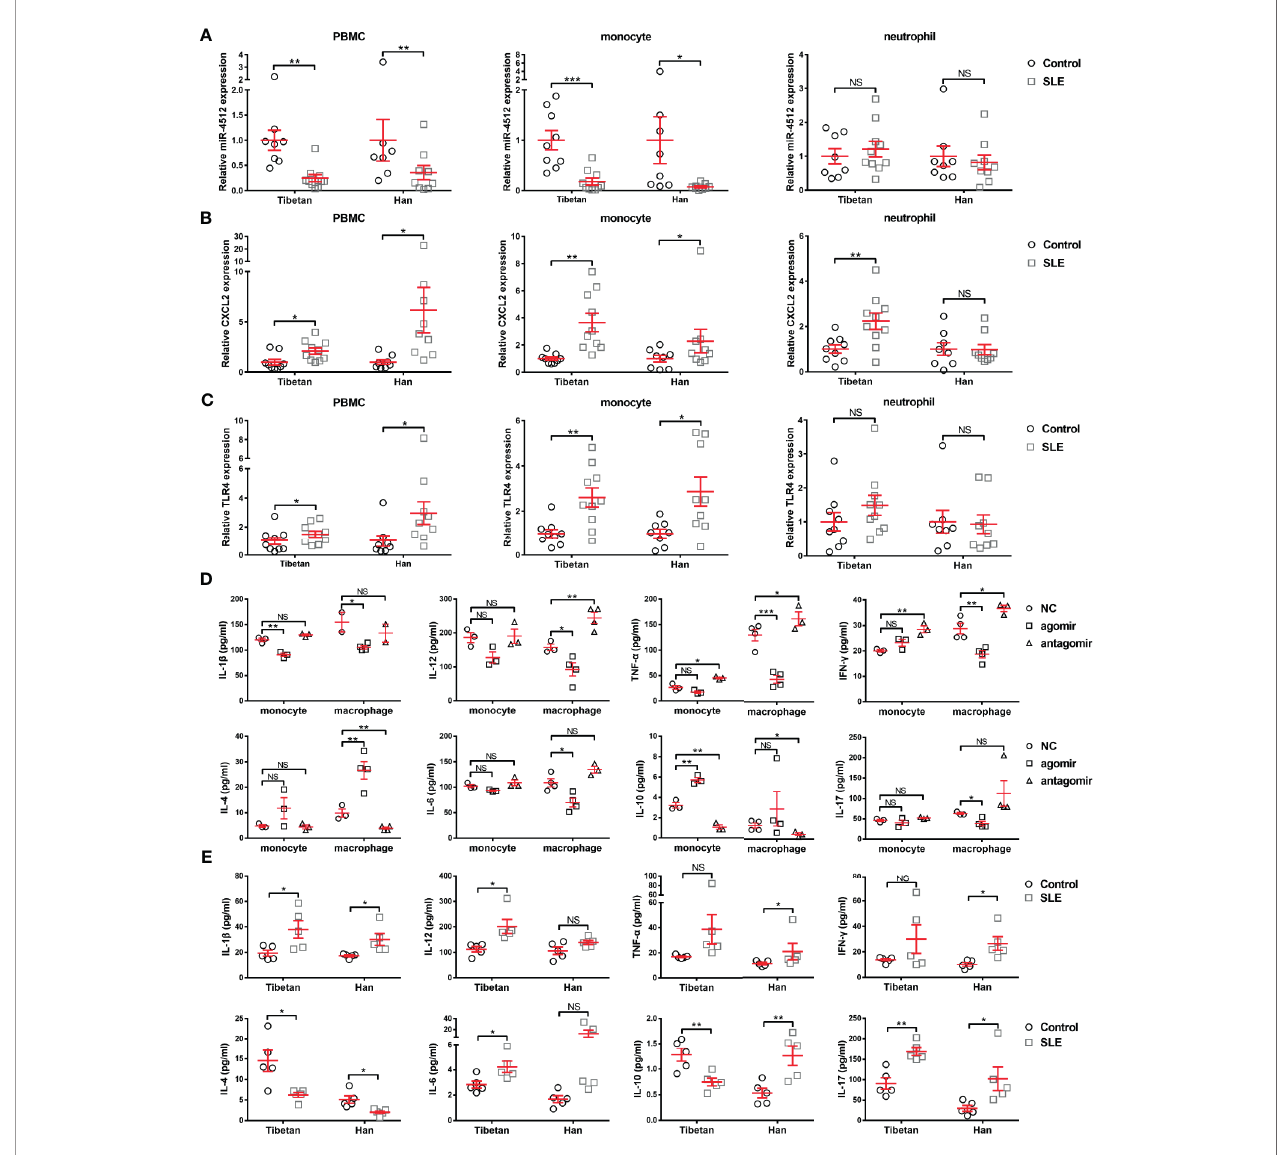
FIGURE 3 | Decreased miR-4512 expression in monocytes and macrophages contributes to a pro-in fl ammatory state. (A – C) Relative expression of miR-4512 (A) , CXCL2 (B) , and TLR4 (C) in PBMC, monocytes, and neutrophils isolated from SLE patients and control subjects, as determined by RT-qPCR. Data are presented as the mean ± SEM. *** P < 0.001; ** P < 0.01; * P < 0.05; NS, not signi fi cant. (D – E) Concentrations of Th1 (including IL-1 b , IL-12, TNF- a , and IFN- g ), Th2 (including IL-4, IL-6, and IL-10), and Th17 (IL-17) cytokines in the supernatants obtained from monocytes and macrophages transfected with NC/miR-4512-agomir/antagomir (D) or in the serum from SLE patients and control subjects (E) , as determined by